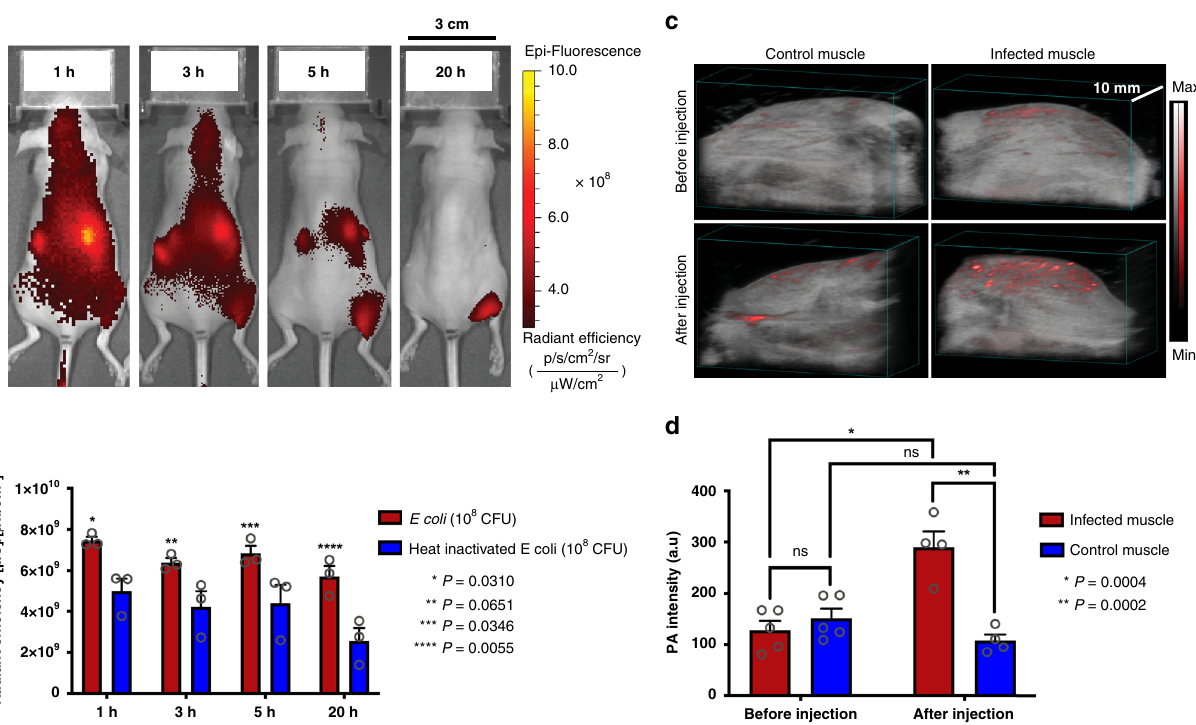
Fig. 3 In vivo validation of Cy7-1-maltotriose in an E. coli -induced myositis murine model. a Fluorescence imaging shows accumulation of Cy7-1- maltotriose in E. coli -infected thigh muscle as early as 1 h post systemic injection (right thigh muscle). No evident accumulation of the agent in thigh muscle injected with 10 8 CFUs of heat-inactivated E. coli (left thigh muscle). b Bar plot representation of quanti fi ed fl uorescence signal in right and left thigh muscle overtime. As early as 1 h post-injection, a signi fi cantly higher fl uorescence signal was found in muscle infected with E. coli (right thigh) compared to muscle infected with heat-inactivated E. coli (left thigh) ( P = 0.0310, n = 3). c 3D rendered photoacoustic image overlaid on ultrasound image of a mouse ’ s left (control) and right (infected) thigh muscle before and 20 h post-injection of Cy7-1-maltotriose. Qualitatively, the image of the infected thigh muscle (bottom right) shows higher photoacoustic signal relative to image of the same muscle acquired before probe injection (top right) and image of the control thigh muscle (bottom left). d Bar plot representation of the quanti fi ed photoacoustic signal intensity in the photoacoustic images acquired before and 20 h after injection of Cy7-1-maltotriose. The quanti fi ed signal of the infected thigh muscle was signi fi cantly higher post-injection of the probe compared to that before injection ( n = 4 and 5 respectively, P = 0.0004). In addition, the post-injection signal in the infected thigh muscle was signi fi cantly higher than that of the control muscle ( n = 4, P = 0.0002). Bar graphs show mean and S.E.M. Statistical analysis was performed using two-way ANOVA. ns no statistically signi fi cant difference ( P > 0.05). The source data underlying Fig. 3b and d are provided in a Source Data fi